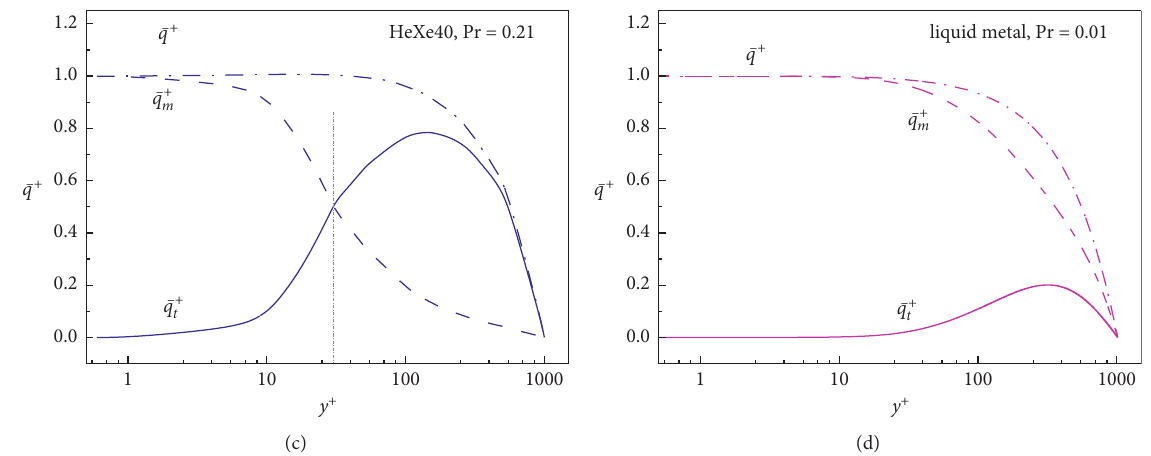
+ � v ′ T ′ ), and total heat flux t